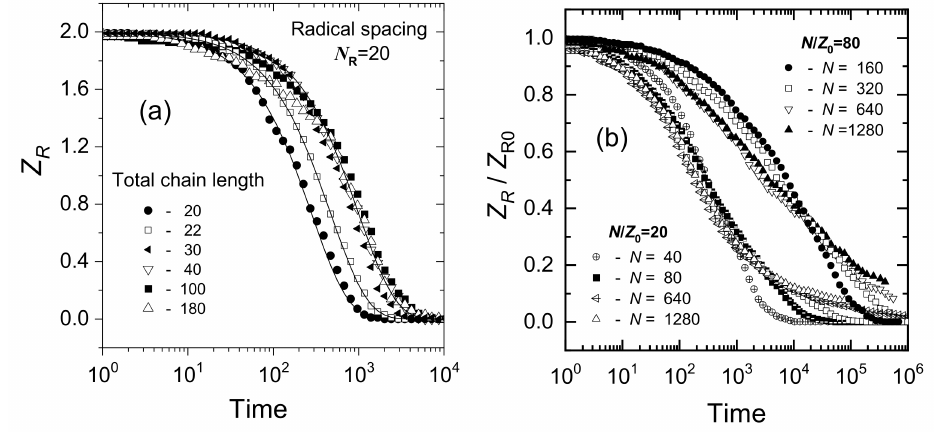
(cid:51) well as for PEO standards of M n = 23 kDa (polymer chain concentration 19 µ M, (cid:3) ), M n = 94 kDa